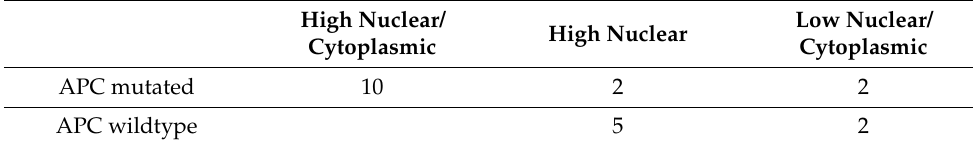
Table 3. APC mutation status.